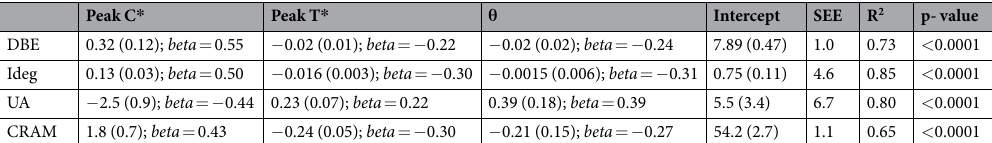
Table 2. Mean values (standard deviation) of the coefficients of the multiple linear regressions (Pearson) for n = 1000 between the intensity-weighted average molecular parameters from FT-ICR-MS analysis of the SPE- DOM (DBE = double bond equivalent 46 , Ideg = degradation index 47 , unsaturated aliphatic compounds (UA) and CRAM = carboxyl rich alicyclic molecules) 67 and potential temperature and the optical properties of the DOM (carbon-specific fluorescence intensity of the humic-like compounds (peak C * ) and the protein-like compounds (peak T * ) in NFIU L mg − 1 C. beta = Normalized regression coefficients, SEE = standard error of estimate in